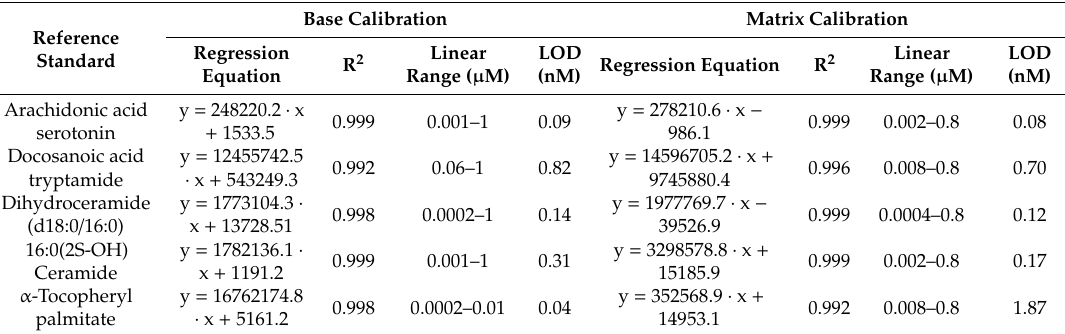
Table 1. Selected validation parameters for base and matrix calibration.